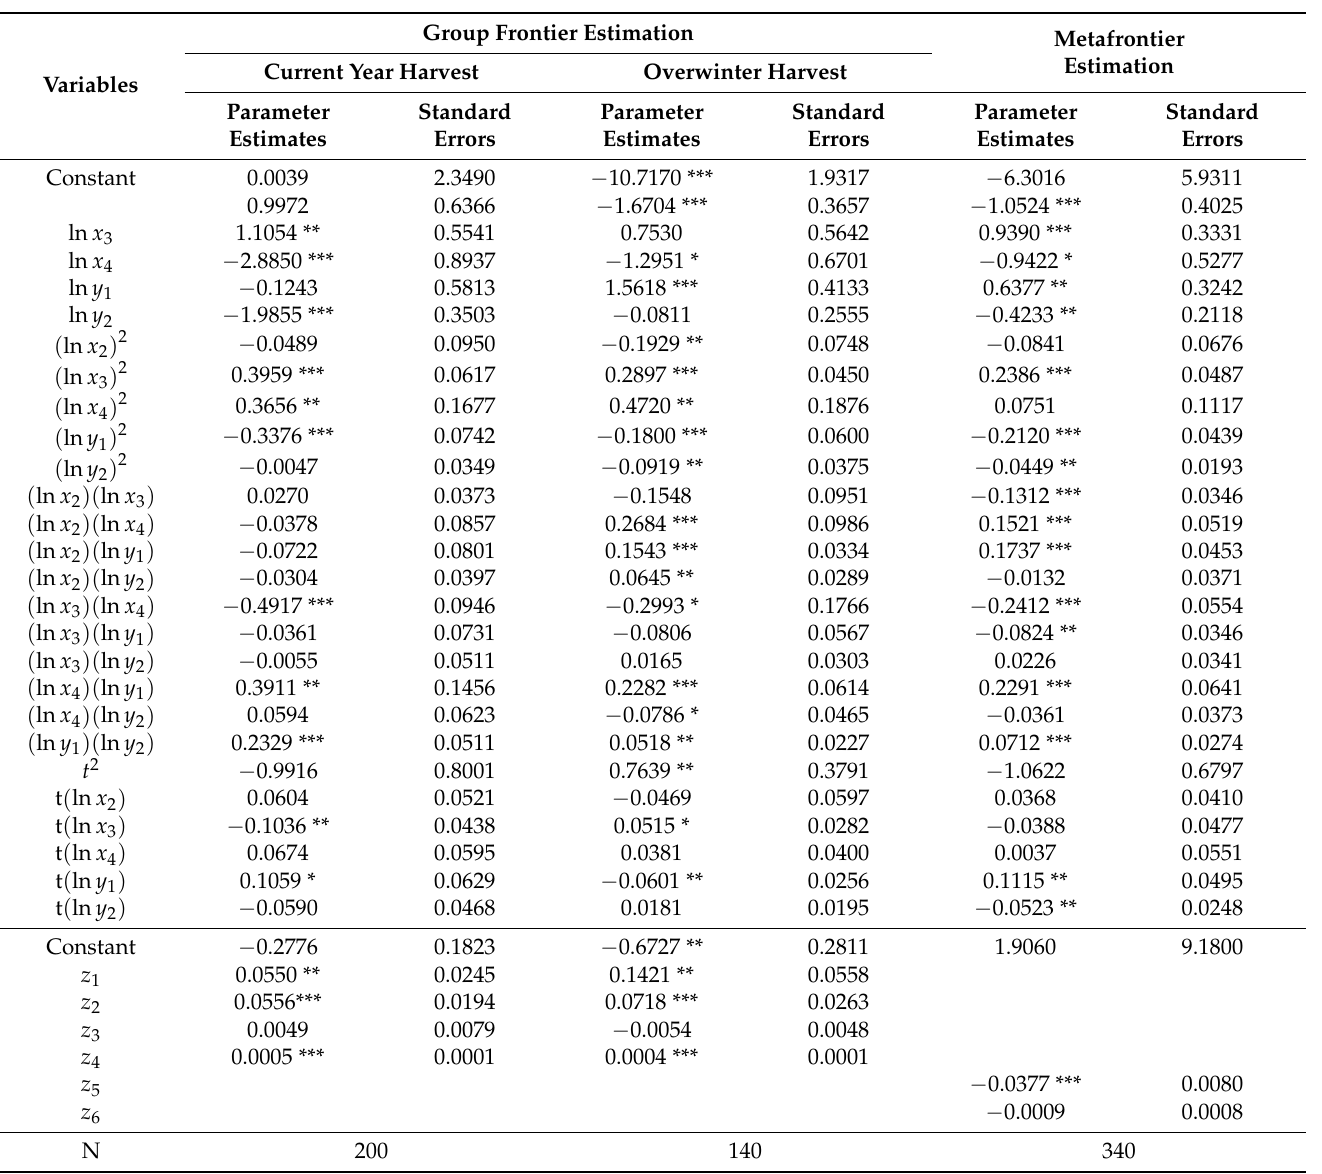
Table 2. Stochastic frontier parameter estimation